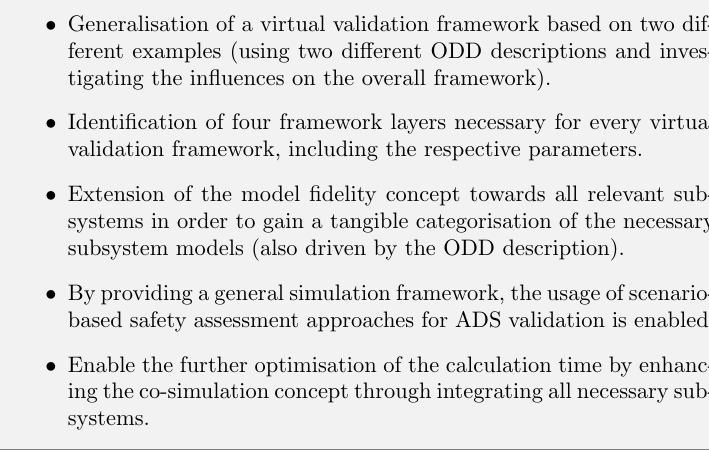
Figure 18. Main contributions of this article to the virtual validation of